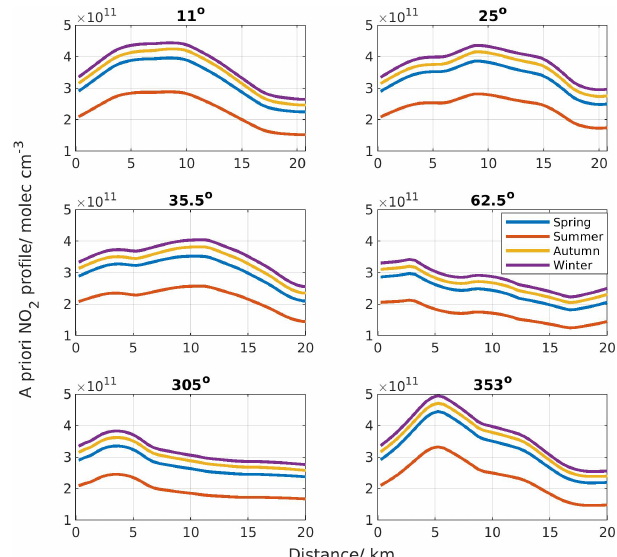
Figure 12. Example of seasonal RIO a priori NO 2 horizontal pro- files for the new horizontal distribution inversion approach as a function of the horizontal distance from the MAX-DOAS instru- ment in six different azimuthal viewing directions, before the appli- cation of the scaling